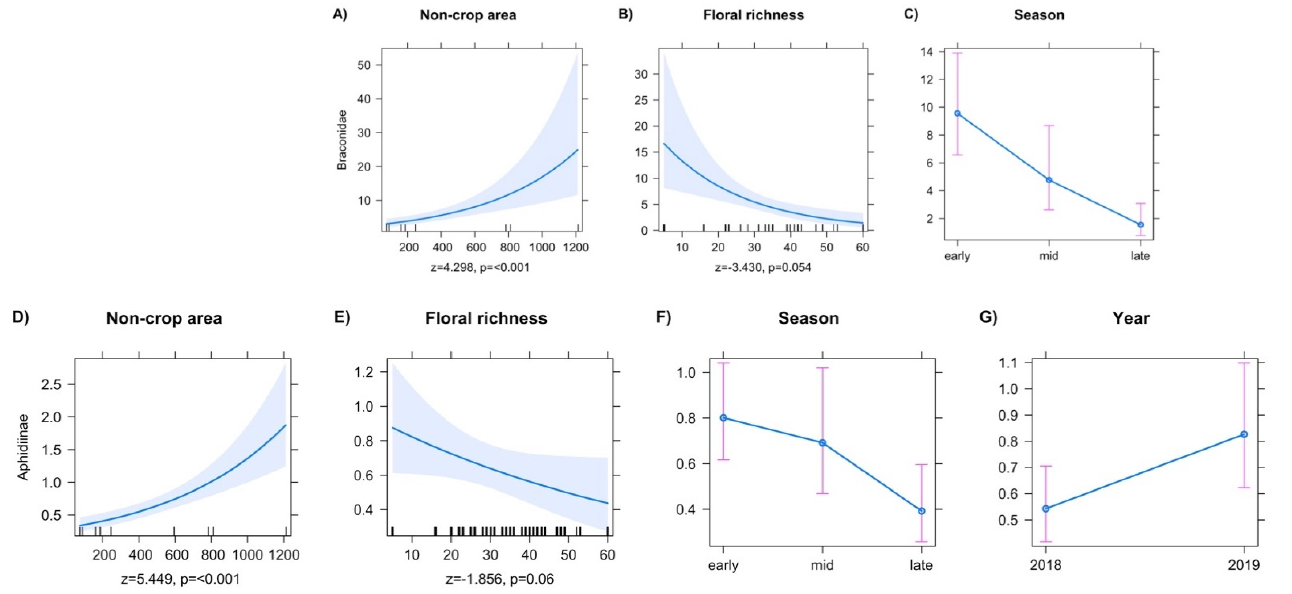
Figure 4. Predictor effect plots for individual explanatory variables on the abundance of family